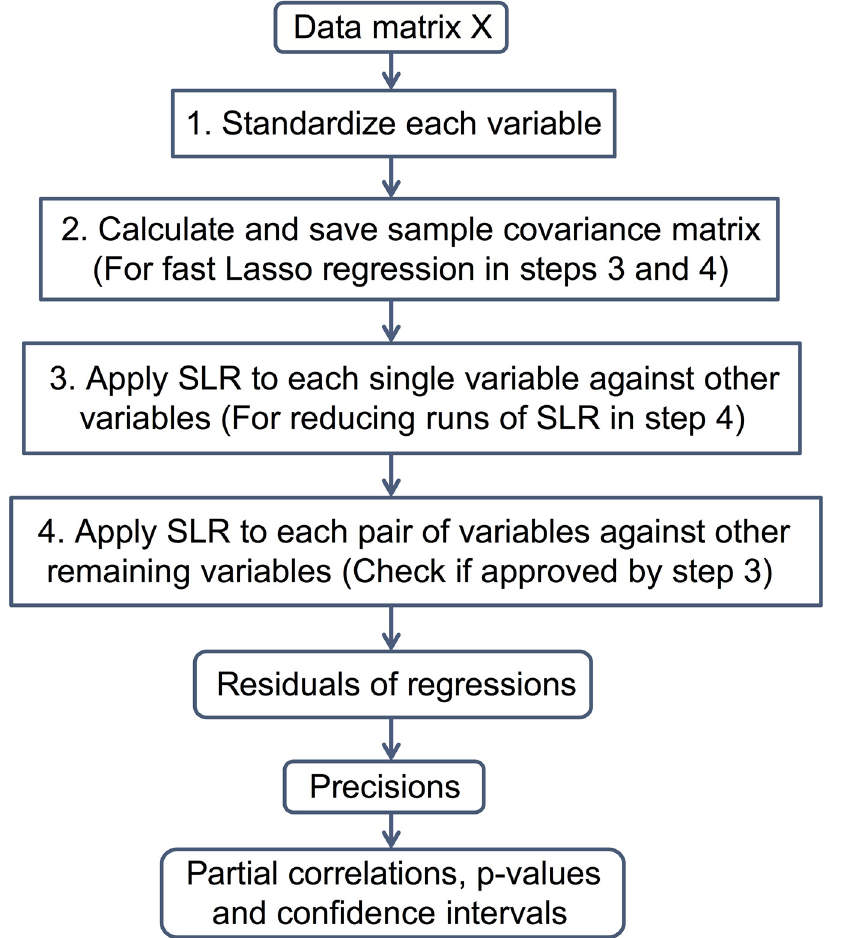
Fig 1. Flowchart of FastGGM